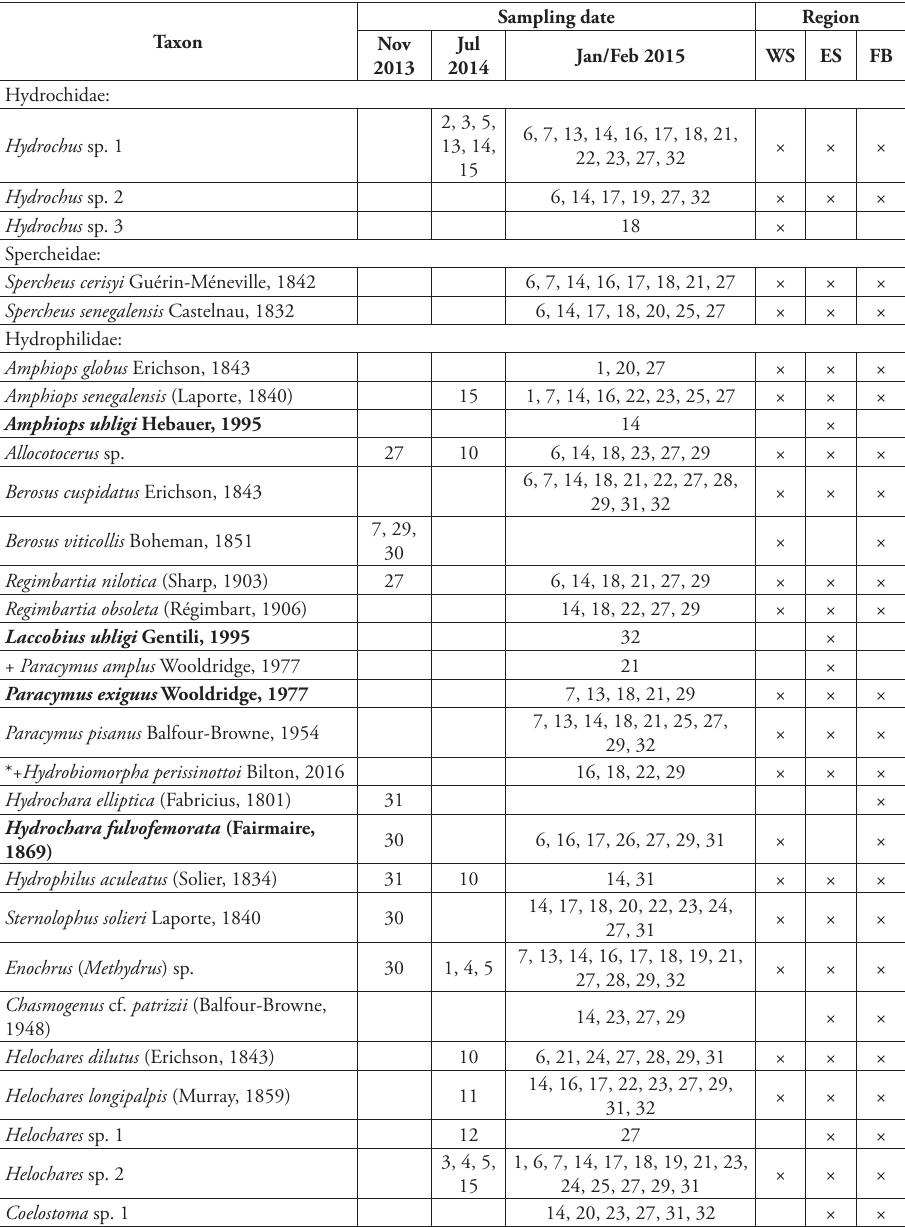
Table 2. Polyphagan beetles collected from St Lucia during the course of this study. The sites are listed from which each taxon was collected on each of the three sampling trips. Site numbers 1 – 32 correspond to those listed in Table 1. The regions where each taxon occurred are also indicated: WS – Western Shores; ES – Eastern Shores; FB – False Bay. Species new to South Africa are shown in bold type. Classification of Hydrophilidae follows Short and Fikáček